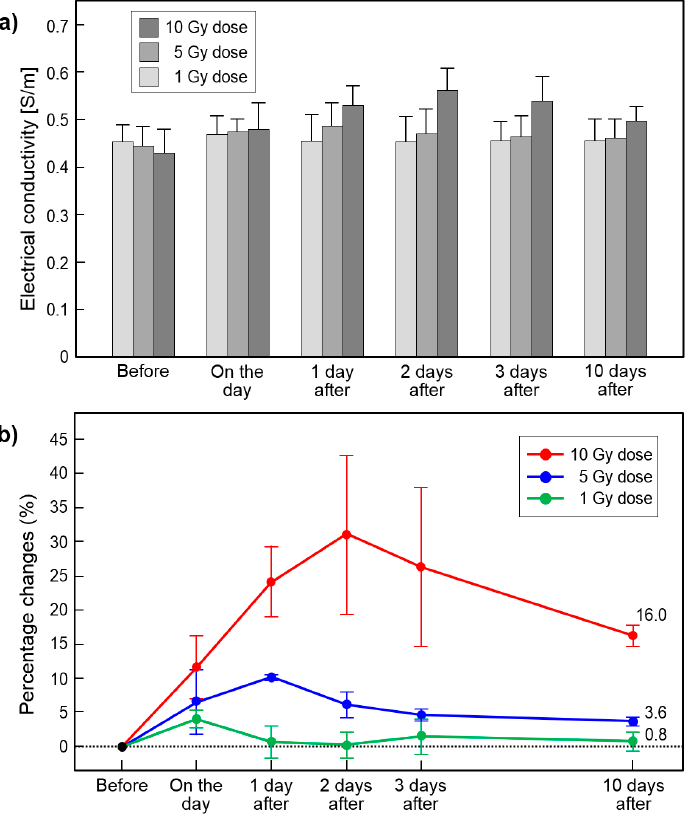
Figure 7. Analysis of in vivo brain conductivity images according to different doses and elapsed time after irradiation. Absolute conductivity ( a ) and relative conductivity changes ( b ) were acquired from doses of 1, 5, and 10 Gy with full time points. Table 2. Summary of electrical conductivity and relative conductivity change (in parentheses) from in vivo mouse brain imaging. The measured conductivity indicates absolute values of the tissue response at three doses. The relative conduc- tivity change indicates the extent of tissue response to irradiation based on the values of pre-irradiation. In Vivo Brain Im- aging